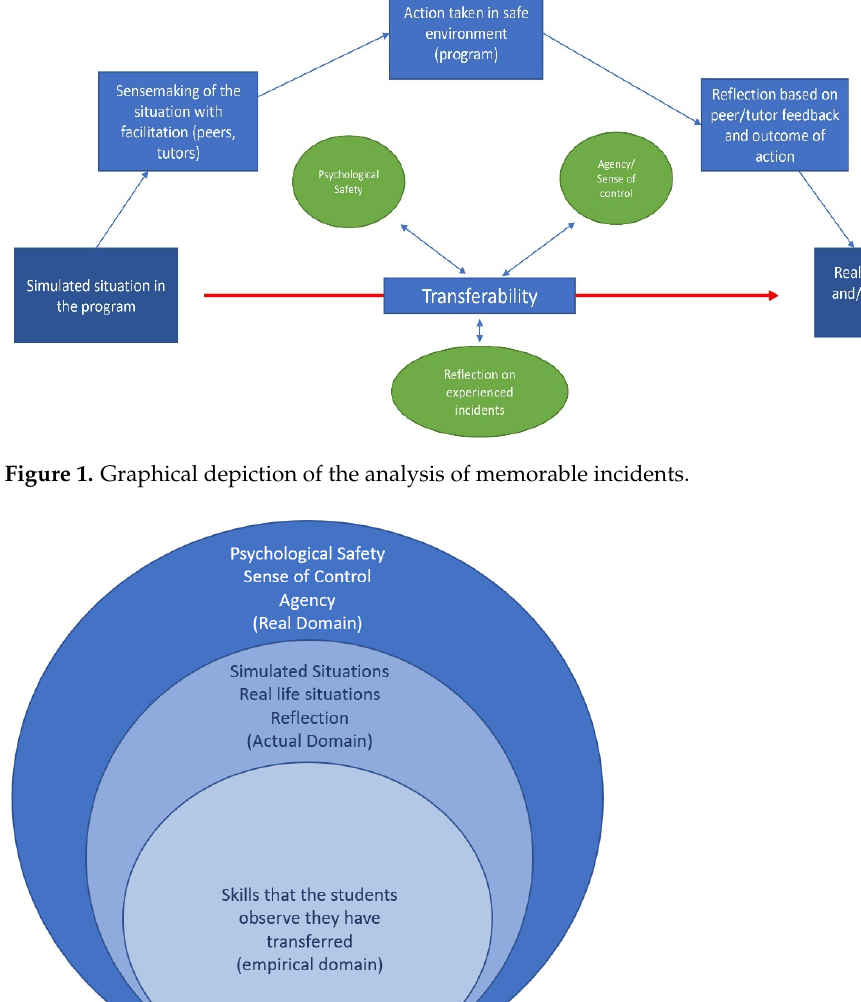
Figure 2. Critical realist depiction of the proposed model. Table 5. Examples of Critical/Memorable Incidents (Excerpts) involving mechanisms for transfera- bility (Mechanisms—real domain) of leadership skills (Skills—empirical domain). Skills—Empirical Domain